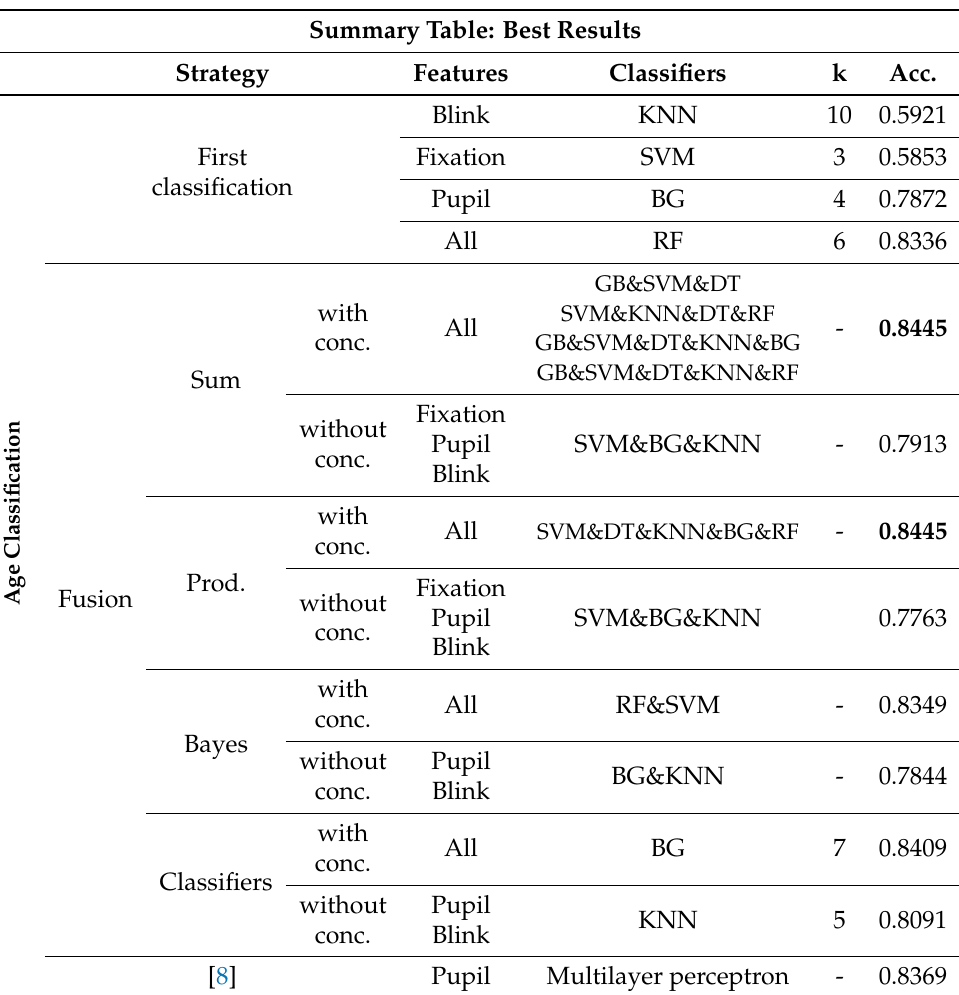
Table 8. For both classification tasks, the results of the single biometric traits (blink, fixation, and pupil) obtained with the same protocol are reported in the first three lines. The next line shows the best results obtained with our fusion strategy. In the last line there is a comparison with a paper that uses the same dataset with the same purpose. The numbers in bold are the best